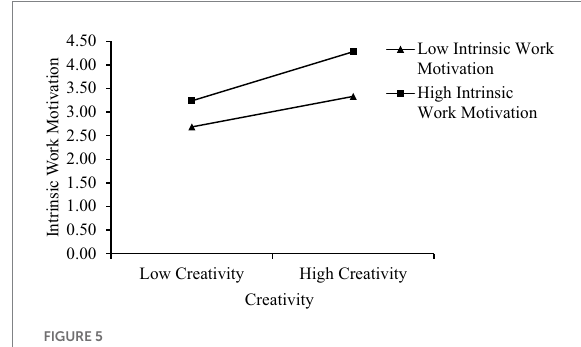
FIGURE 3 The slope of the moderating effect of work enjoyment.